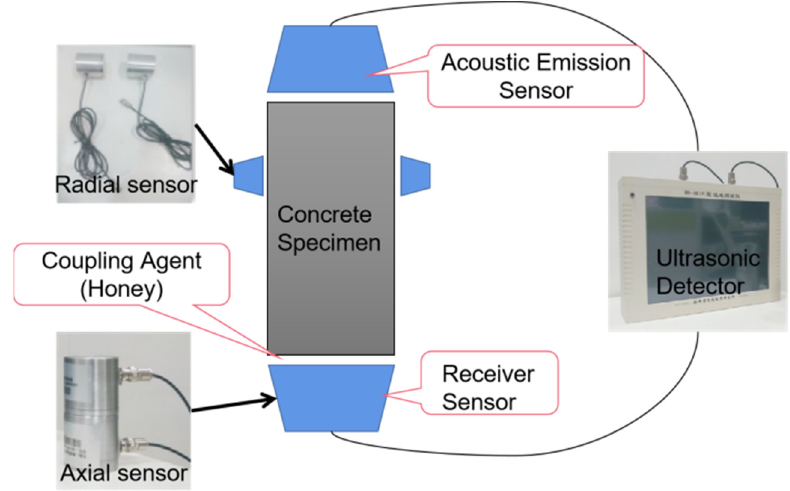
Figure 2. Ultrasonic testing system.